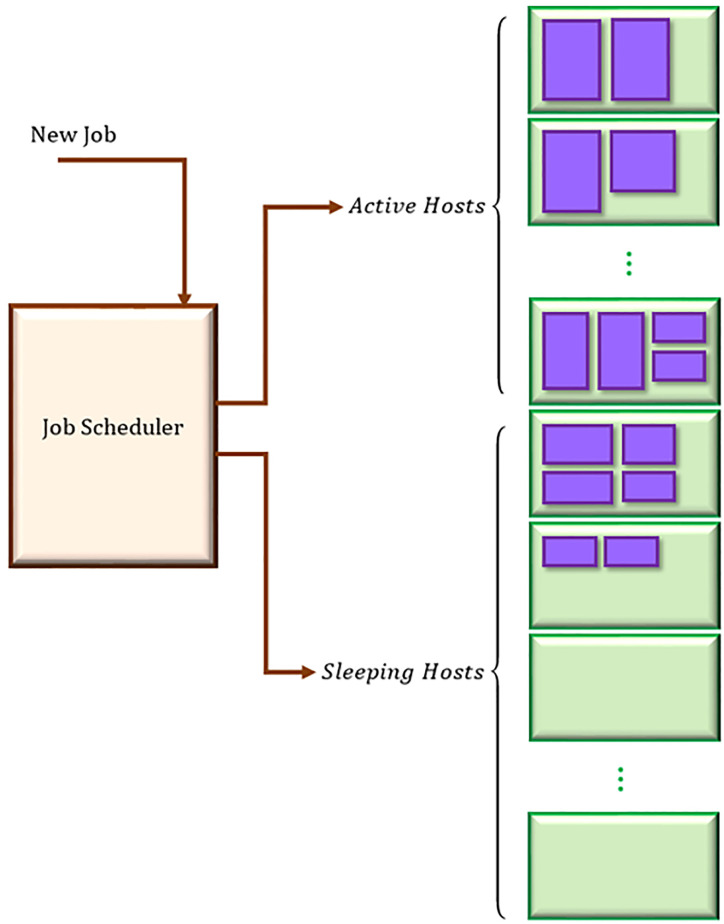
The proposed model.